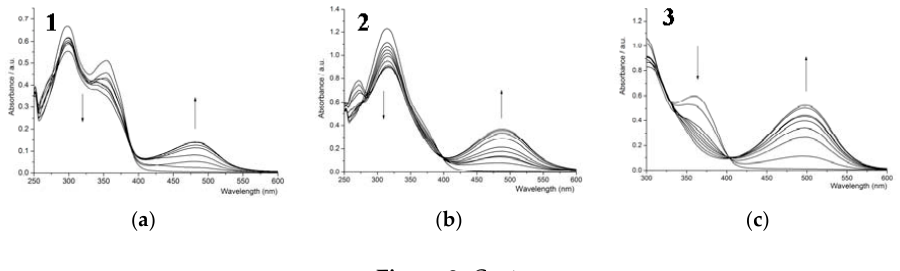
Figure 1. SEM images of compounds. ( a ) Compound 2 ; ( b ) Compound 3 ; ( c ) Compound 4